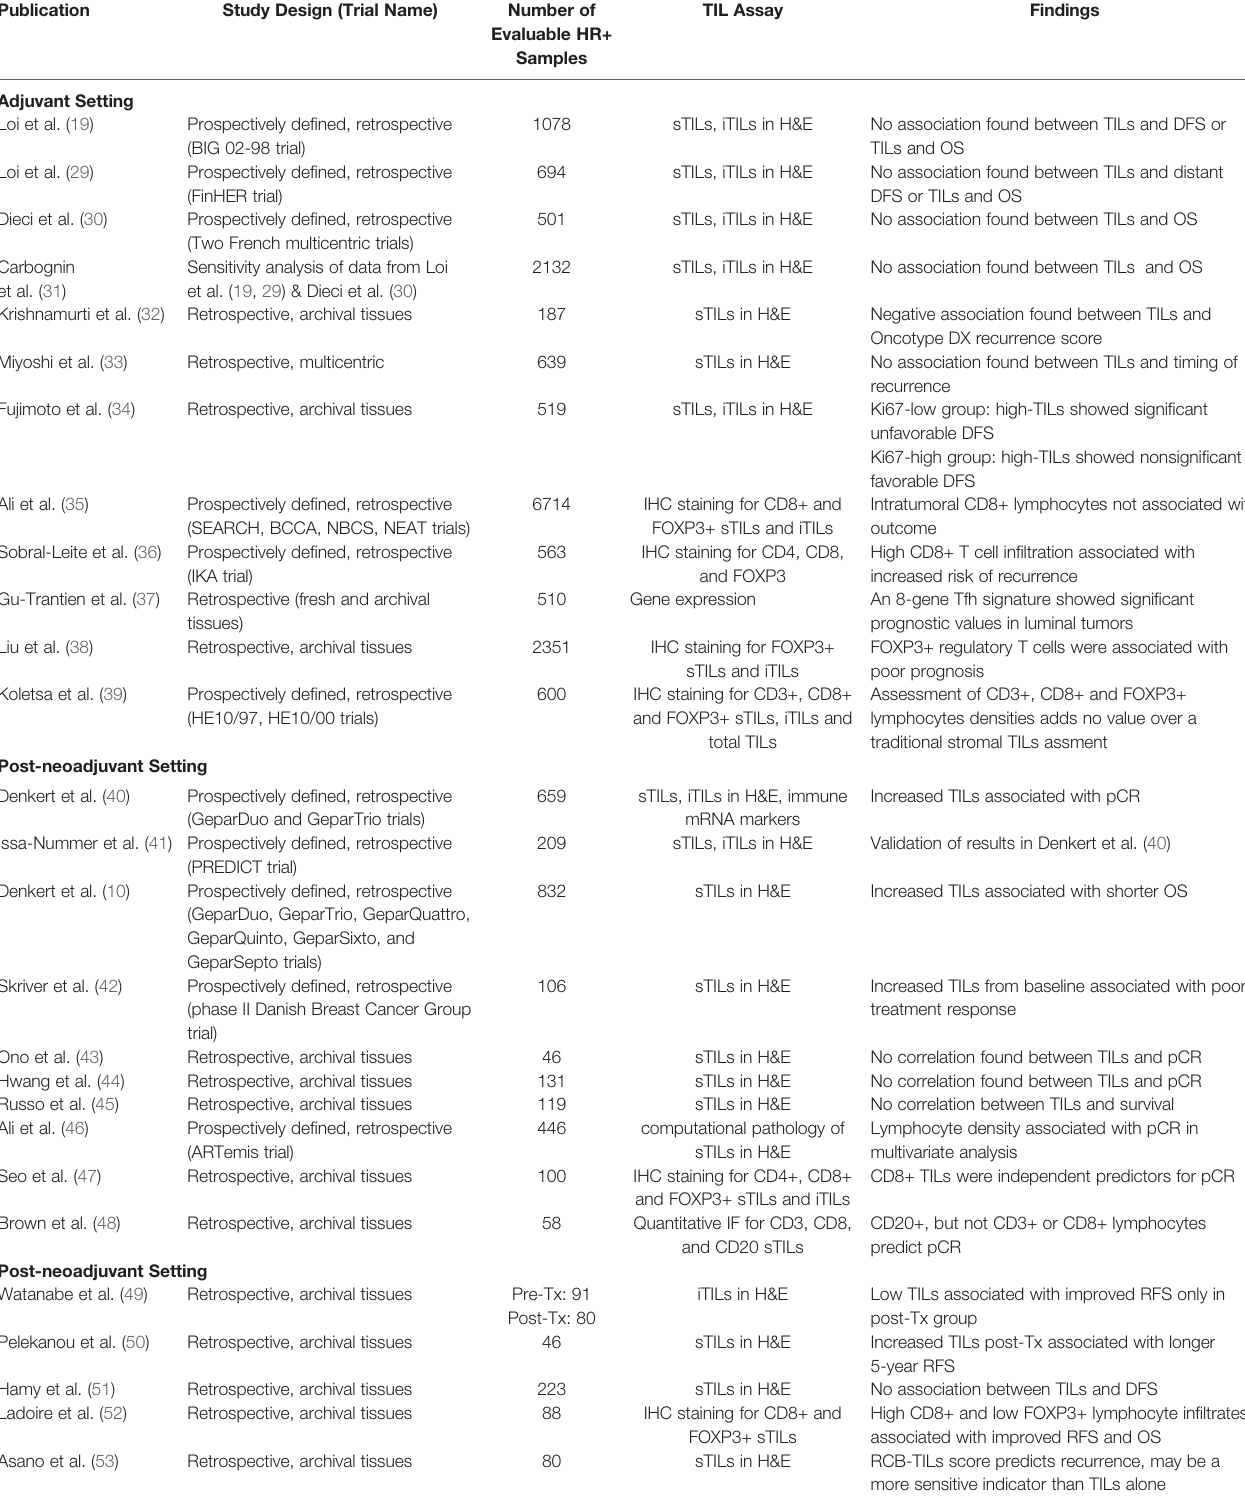
TABLE 1 | Summary of the association of tumor in fi ltrating lymphocytes (TILs) in HR+ breast cancer with clinical